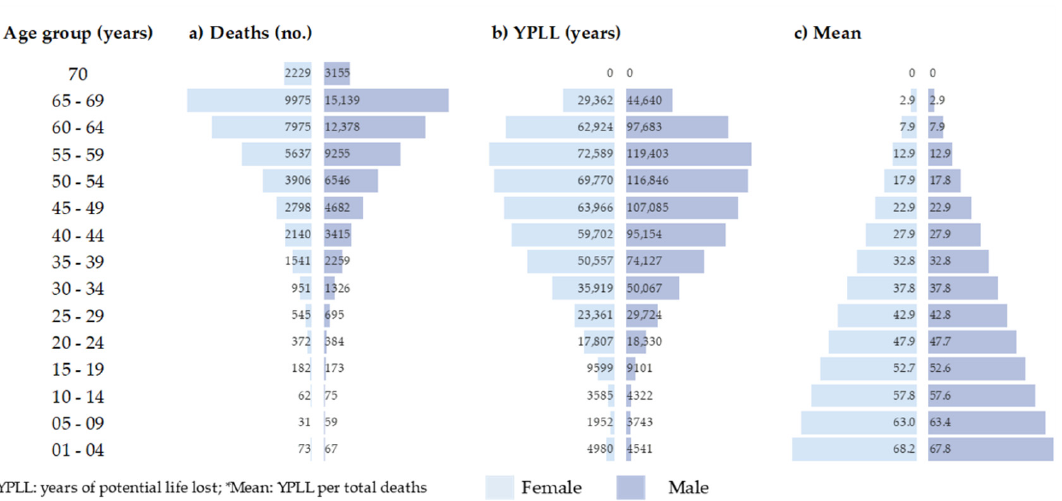
Figure 2. Deaths and years of potential life lost due to COVID-19 in Brazil (2020) by gender and age group. Of the YPLLs, 889,771 (69.3%) occurred among those who had a risk factor. Women with risk factors accounted for 74.1% of the YPLLs, with an average of 12.7 years for each death. Among the deaths with risk factors, chronic cardiovascular disease and diabetes mellitus represented 365,541 and 335,956 YPLLs, respectively (Figure 3). It should be noted that a single death record can be associated with more than one risk